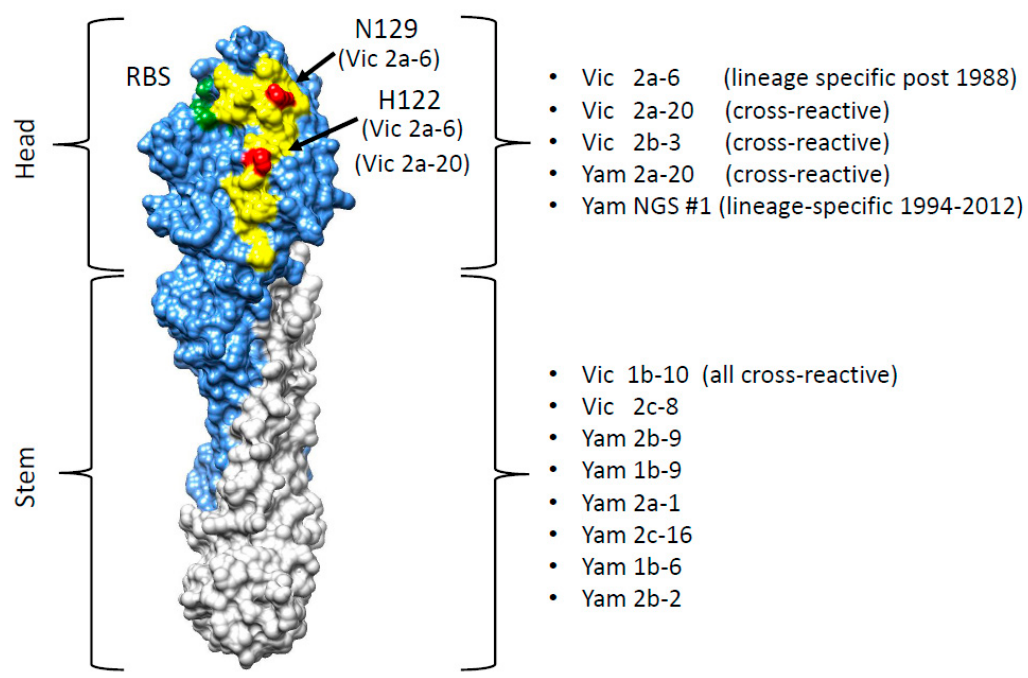
Figure 6. Correlation of the sdAb epitopes with the Hemagglutinin structure. The structure of the HA0 monomer (B/Brisbane/60/2008 PDB structure 4FQM) is shown with the HA1 domain in blue, the stem region in grey, the 120 loop in yellow and the receptor binding site (RBS) in green. The residue of H122 and N129 associated with the B-Victoria lineage-specific binding of the sdAb Vic2a-6 or preferred binding of the Vic2a-20 are shown in red. The binding specificity of the sdAb panel are shown in relation to the HA head and stem region.